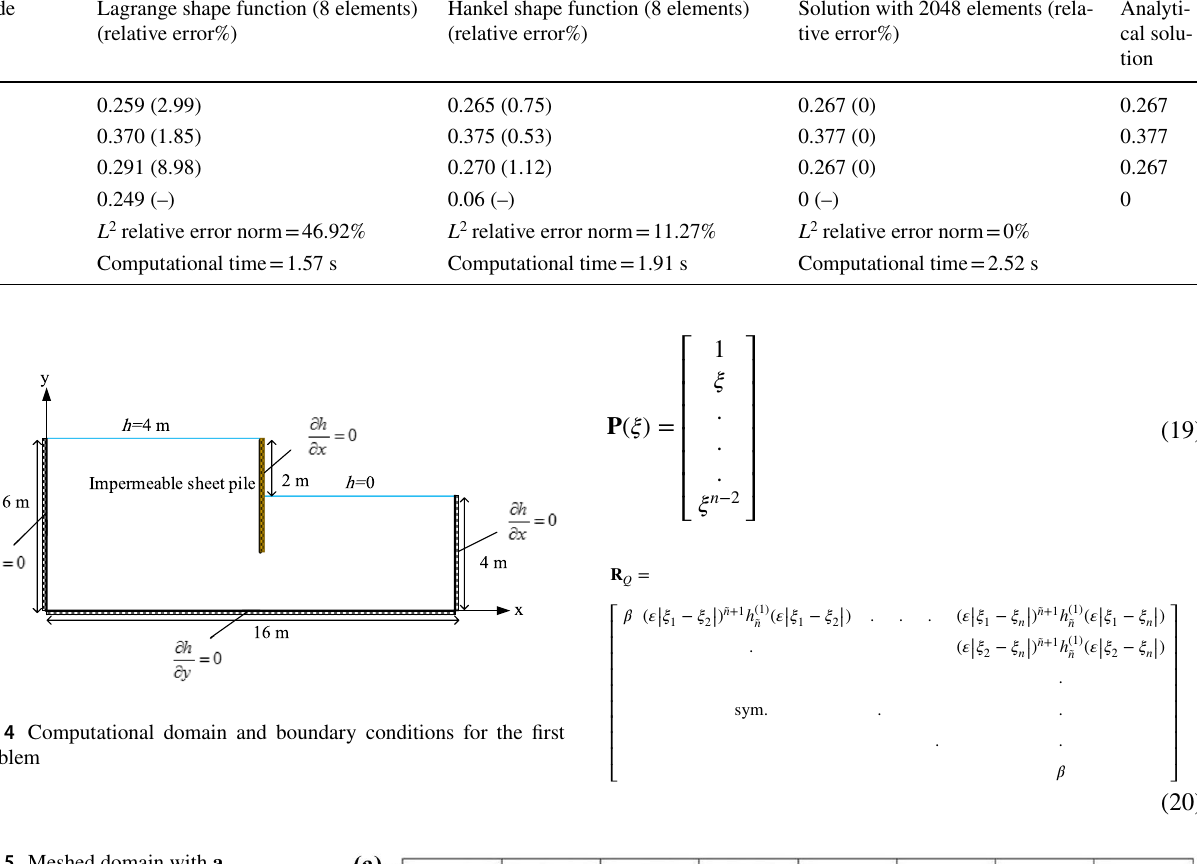
Fig. 5 Meshed domain with a 1280 elements, b 10-element for the first